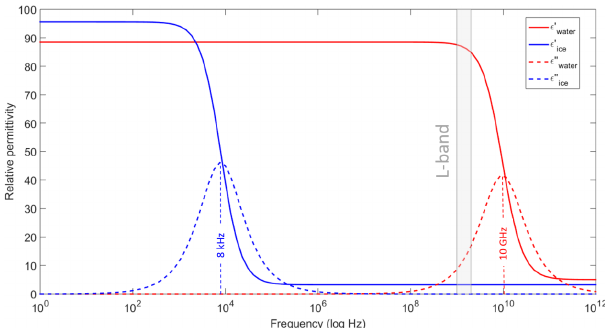
Figure 1. Real ( ε (cid:48) ) and imaginary ( ε (cid:48)(cid:48) ) parts of the relative permit- tivity (unitless) of water and ice at 273K according to the Debye relaxation model (Mätzler, 1987; Artemov and Volkov,